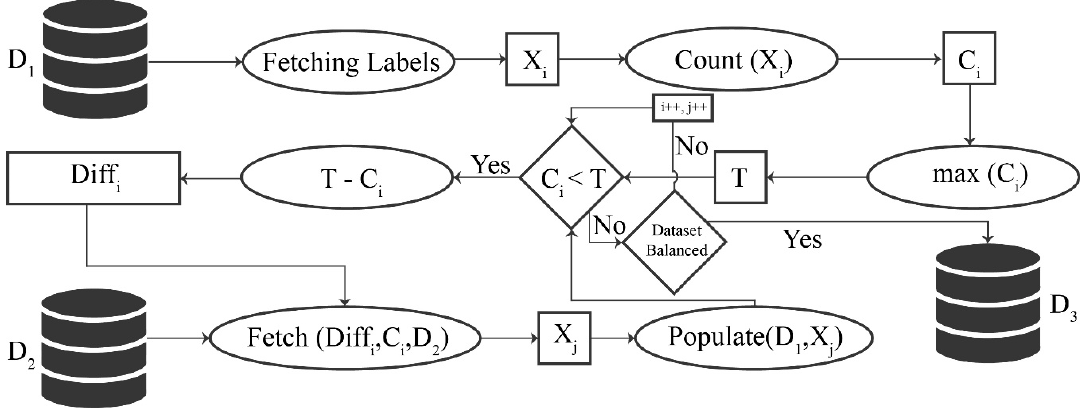
Figure 2. Flow diagram of data augmenter.